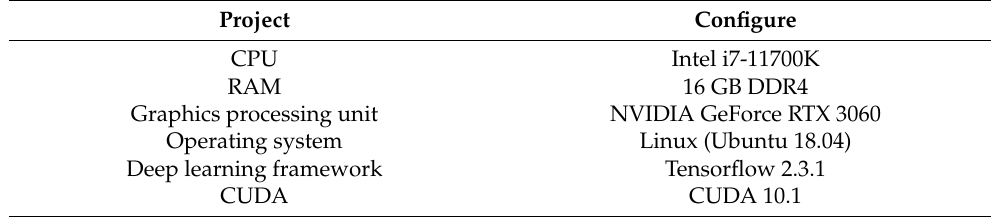
Table 5. Mobile workstation hardware and software details.